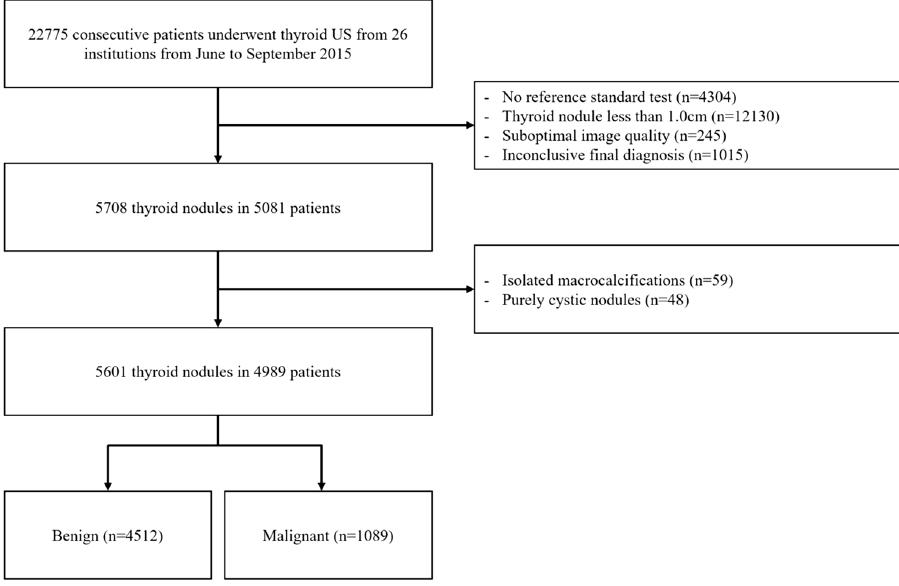
Figure 1. Flowchart of the study. US = ultrasonography, numbers are nodules numbers, unless otherwise